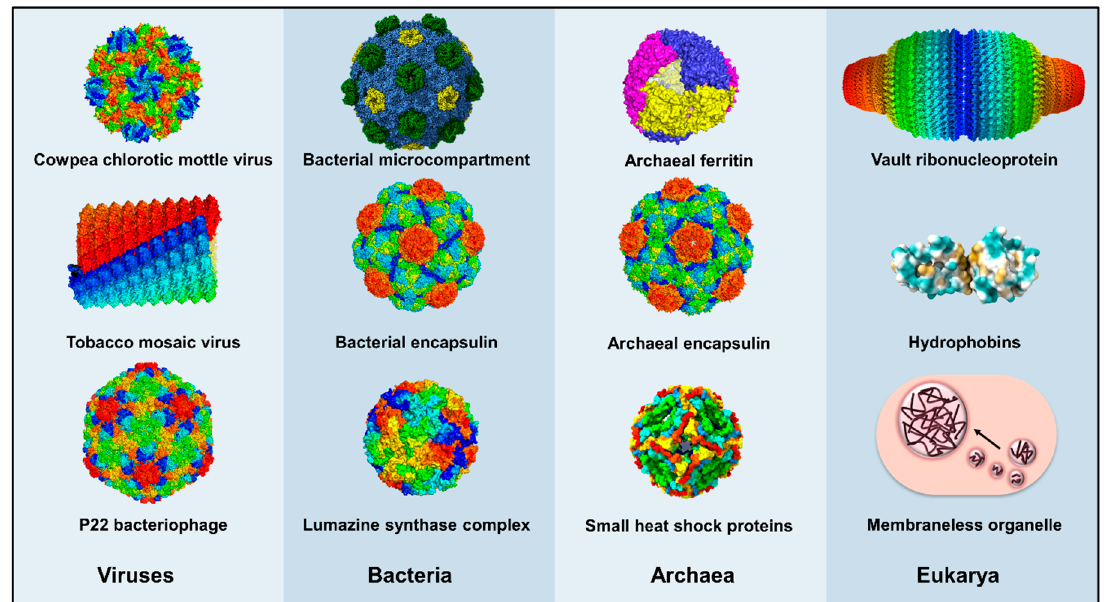
Figure 2. Structural models of some proteinaceous shells and scaffolds, from viruses and the three established domains of life, that have been engineered to host foreign enzymes. Surface representations are used for protein shells with known atomic-level structural models. For heteromeric shells, each component is colored differently to aid differentiation. For homomeric shells, selected polypeptide chains are colored discretely before applying appropriate symmetries to construct the intact shell. A hydrophobic surface representation is used for hydrophobins (cyan for hydrophilic, brown for hydrophobic). Atomic-level structures are not known for MOs, and a schematic of aggregation of spherical globules representing MO formation within a cell is shown. Models are not depicted to scale. The PDB accession codes used to generate these models are: 1ZA7 (cowpea chlorotic mottle virus [38]), 6R7M (tobacco mosaic virus [39]), 5UU5 (P22 bacteriophage [40]), 5V74 (bacterial microcompartment [41]), 4PT2 (bacterial encapsulin [42]), 1HQK (lumazine synthase [43]), 1S3Q (archaeal ferritin [44]), 2E0Z (archaeal encapsulin [45]), 1SHS (heat shock protein [46]), 4V60 (vault [47]), and 1R2M (hydrophobin [48]). Models were generated using UCSF Chimera and PyMOL [49,50]. Table 1. Properties of some protein compartments and scaffolds that have been modified to host enzymes. Protein Compartment/Scaffold